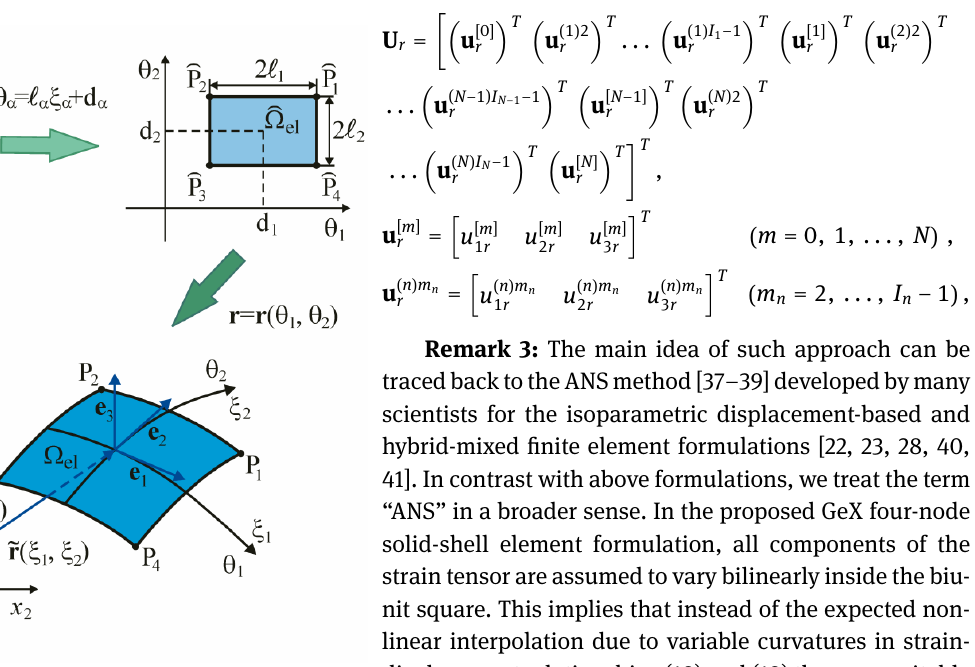
Figure 3: Biunit square in ( ξ 1 , ξ 2 ) -space mapped into the middle surface of the GeX four-node solid-shell element in ( x 1 , x 2 , x 3 ) -space.